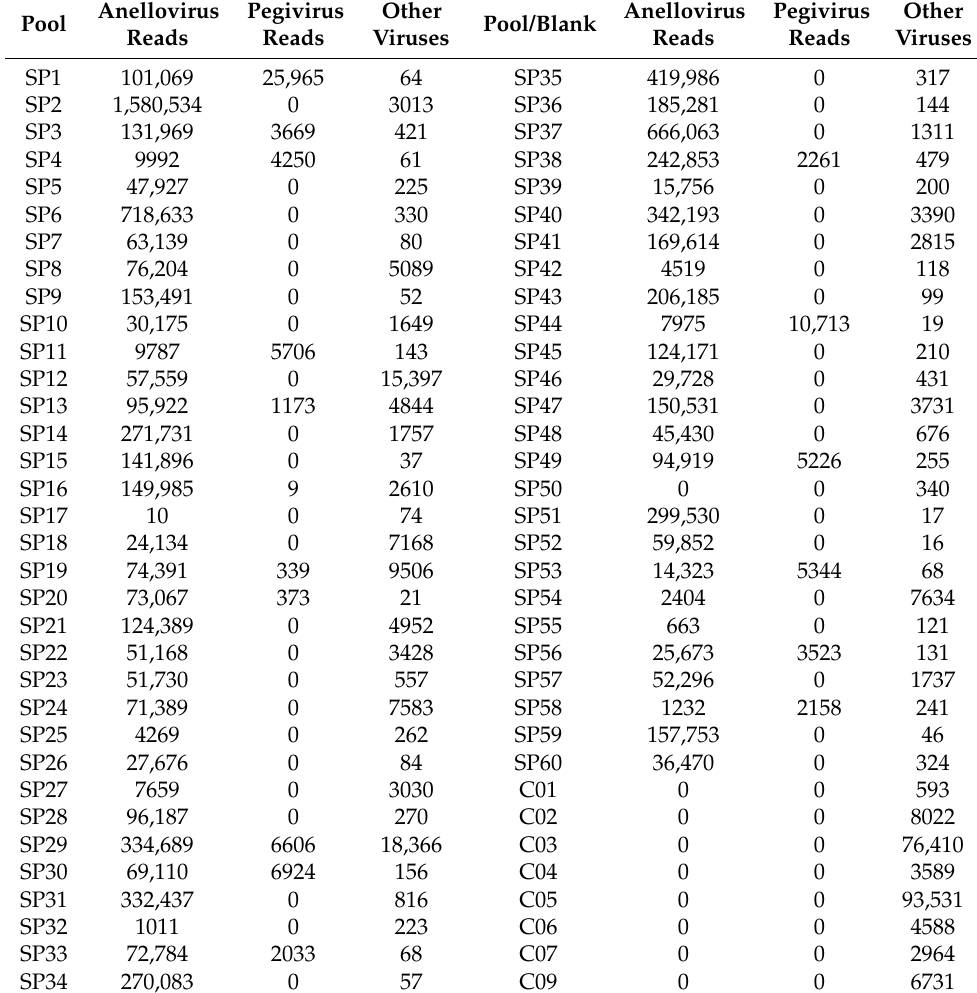
Table 1. Summary of virome composition for the 60 pools analyzed. Read numbers are given. For comparison, the number of reads for the eight blank controls processed are also shown and subsequently used for computational subtraction of potential